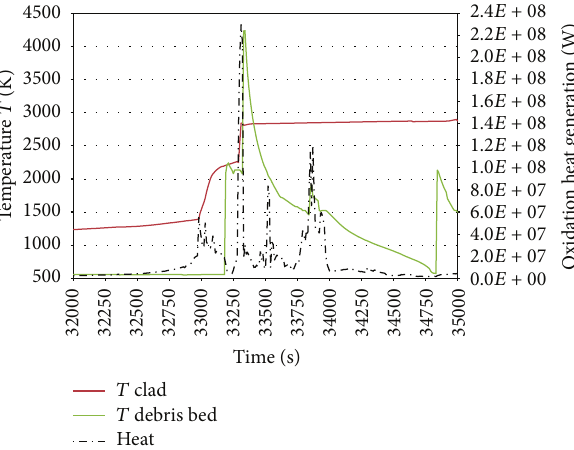
Figure 11: Pressureand void fraction in containment during the first hours of the SBO.